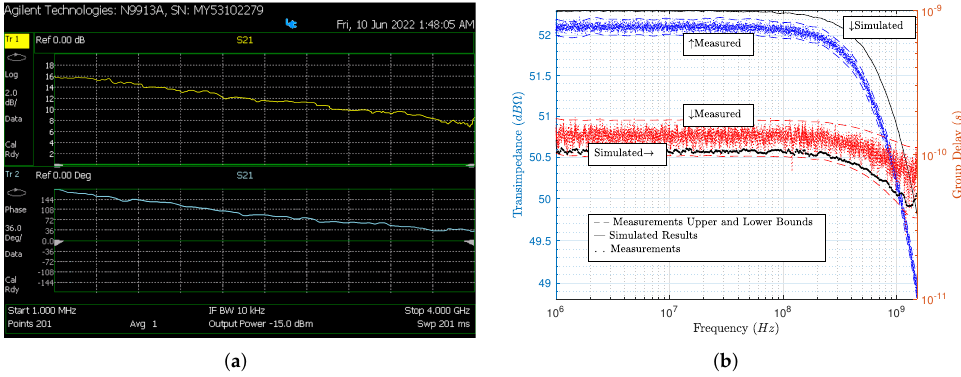
Figure 11. Measured frequency response of DIE: ( a ) S21 s-parameter, where magnitude and phase are colored in yellow and blue, respectively; and ( b ) transimpedance and group delay in blue and red,